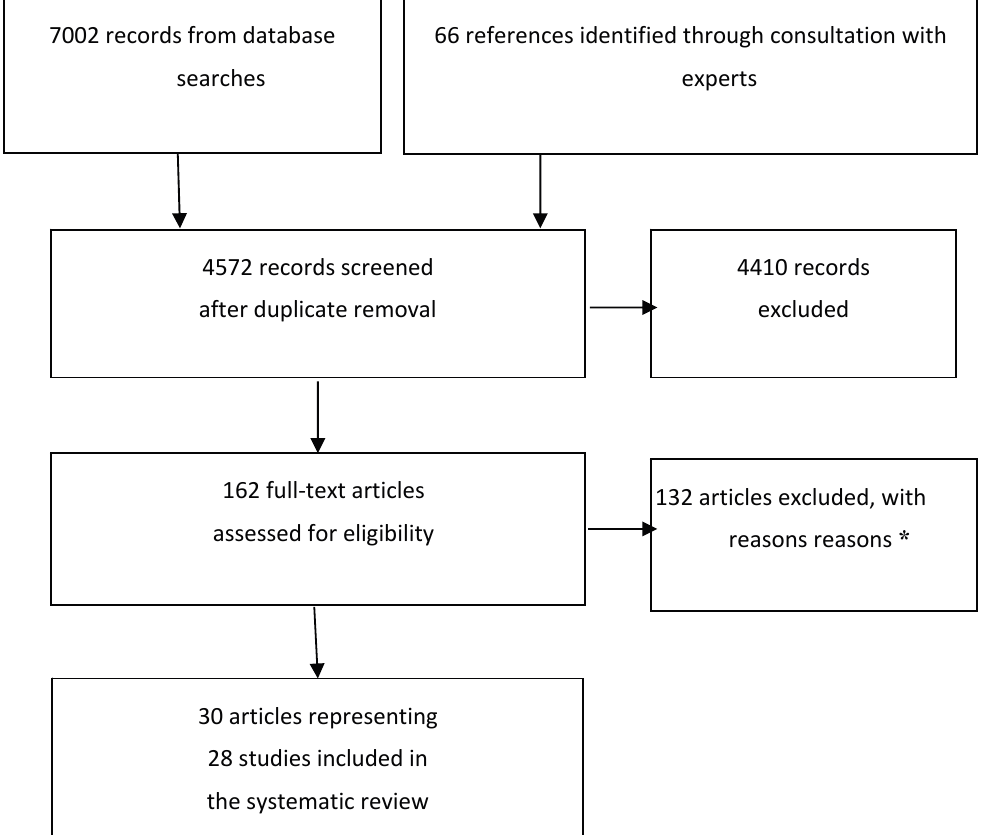
Figure 1. PRISMA flow diagram. * Reasons for exclusions included ineligible exposure (n = 37), ineligible comparator (n = 28), ineligible outcome (n = 39), ineligible population (n = 1), other (includes non-relevant content, review, conference abstract, editorial, incorrect reference (n = 27). Many studies were excluded for multiple